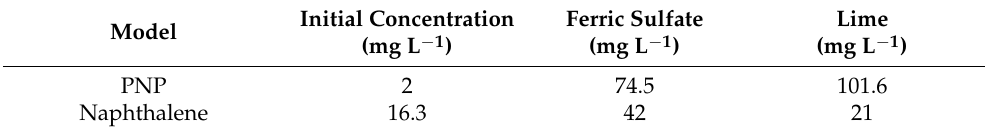
Table 1. Optimal conditions for PNP and naphthalene removal 1 .